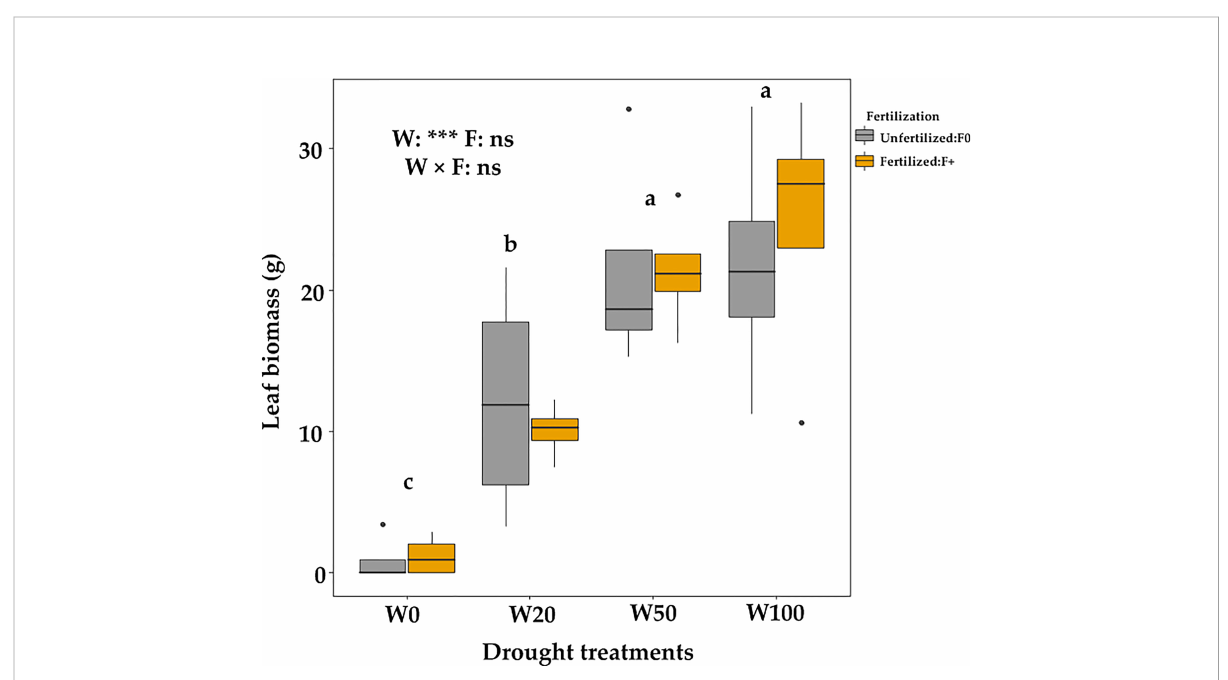
FIGURE 5 Leaf biomass of downy oaks (harvested in July, 2017) under different drought and fertilization treatments.